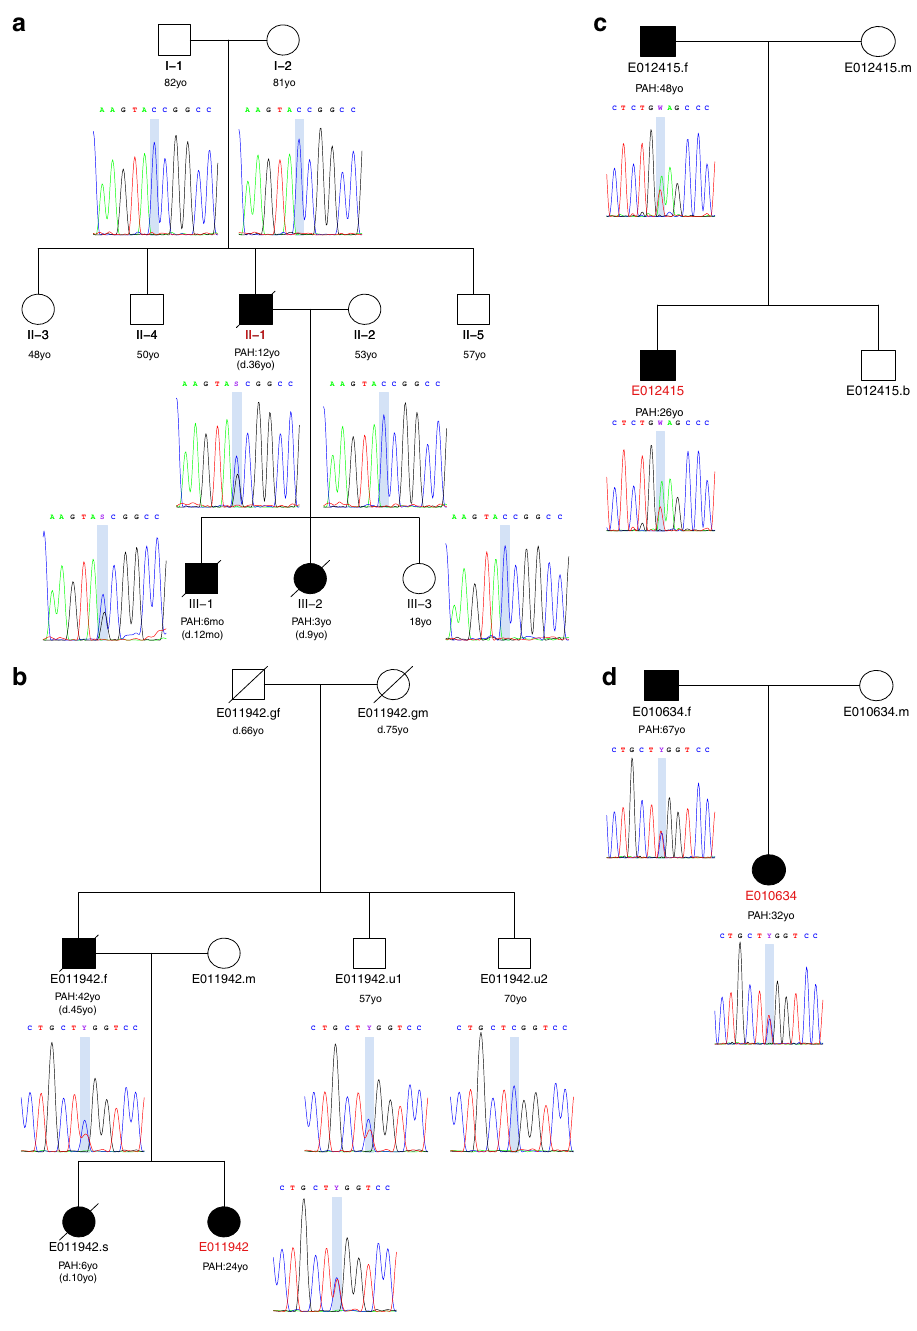
Fig. 4 Pedigree structures and analysis of familial transmission of variants in AQP1 and SOX17 . a Individual II.1 harbours a heterozygous de novo SOX17 c.411 C > G (p.Y137*) PTV resulting in a premature termination codon, which has been transmitted to the affected male (III.1). No unaffected family members carry the variant. No sample was available from subject III.2. b Proband E011942 has inherited a heterozygous AQP1 c.583 C > T (p.R195W) missense variant from her affected father. No sample was available from the affected sister of the proband. The younger healthy uncle of the index case also carries the AQP1 variant. No samples or further clinical information was available for the grandparents, who were not known to have cardiopulmonary disease. c Both the proband E012415 and her father are affected and carry the rare AQP1 c.527 T > A (p.V176E) missense variant. There was no further information available about the siblings of the father. d Subject E010634 has inherited the heterozygous AQP1 c.583 C > T (p.R195W) missense variant from her affected father. No rare variants in previously reported PAH genes were identi fi ed in any of theses families. Index cases are highlighted in red. d death, mo months old, yo years